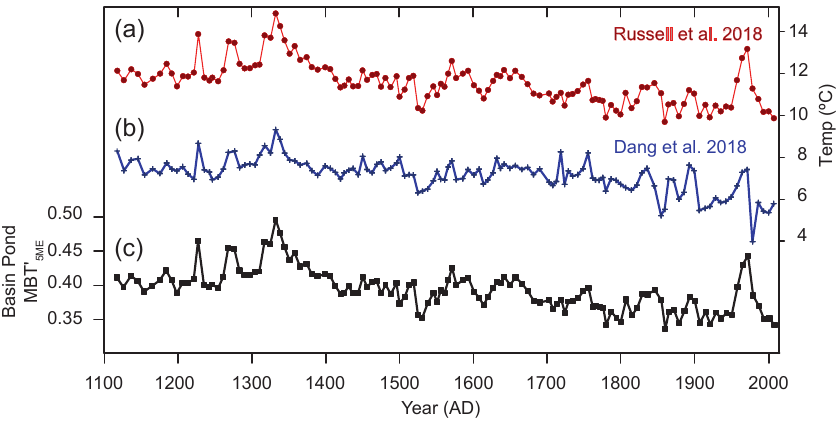
with newly published temperature calibrations. (a) Core BP2014-5D plotted using the Figure 7. Comparison of Basin Pond MBT (cid:48) 5ME African lakes calibration (Russell et al., 2018) and the (b) Chinese lakes calibration (Dang et al., 2018). (c) Basin Pond MBT (cid:48)